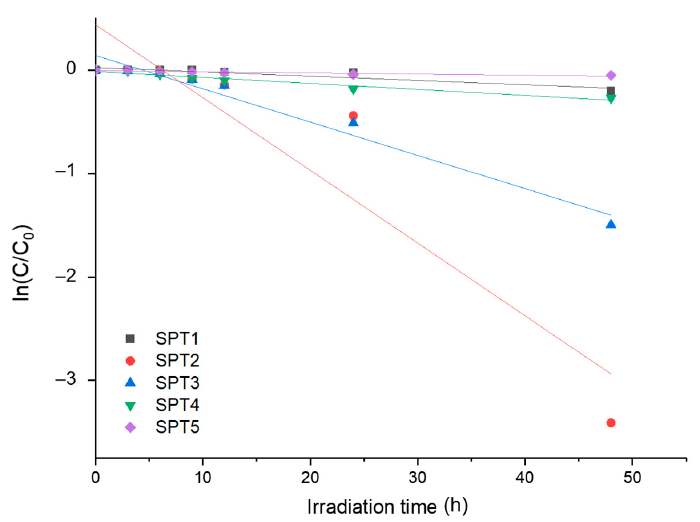
Figure 9. ln( C / C 0 ) versus time plots for the evaluation of the rate constant ( κ app ) for 48 h. SPT1 = TiO 2 Figure 9. ln(C/C 0 ) versus time plots for the evaluation of the rate constant ( (cid:2018) (cid:3028)(cid:3043)(cid:3043) ) for 48 h. SPT1 = TiO 2 (0 (0 mg / L); SPT2 = TiO 2 (100 mg / L); SPT3 = TiO 2 (500 mg / L); SPT4 = TiO 2 (1000 mg / L); SPT5 = TiO 2 mg/L); SPT2 = TiO 2 (100 mg/L); SPT3 = TiO 2 (500 mg/L); SPT4 = TiO 2 (1000 mg/L); SPT5 = TiO 2 (20,000 (20,000 mg / L). Note that the red circles for SPT2 are overlapping with another mg/L). Note that the red circles for SPT2 are overlapping with another symbol.